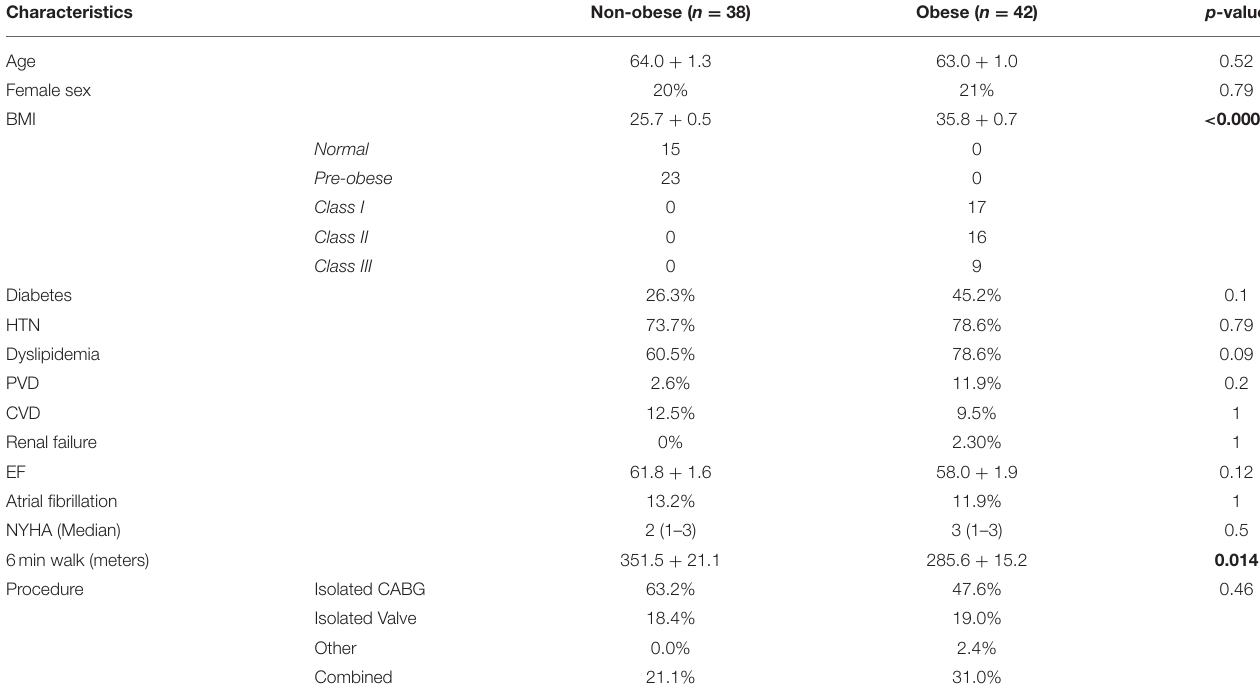
TABLE 2 | Patient characteristics.